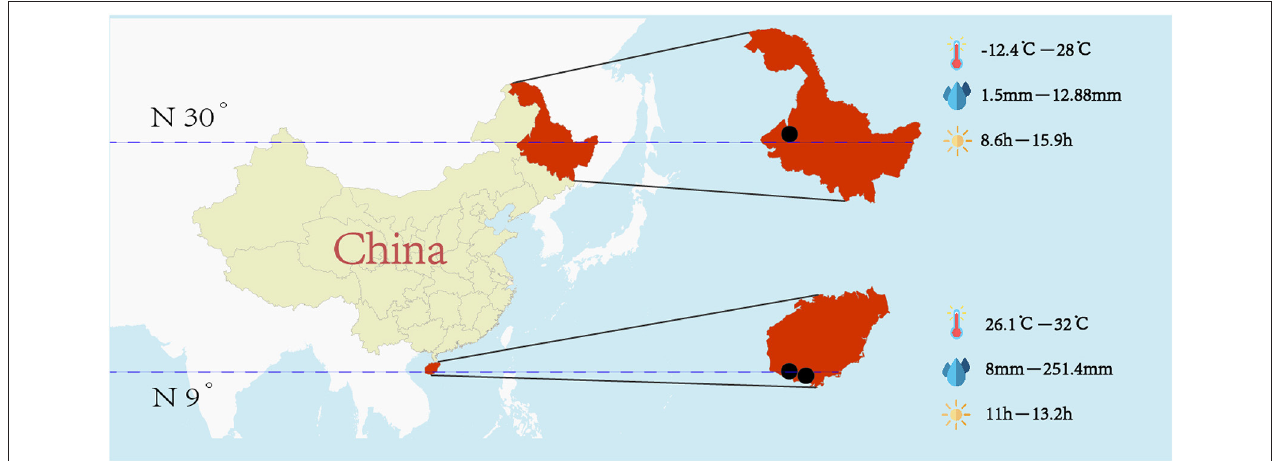
FIGURE 1 | Geographical location and climatic characteristics of the three sample troops. including 560 sailors in total, in this study. In the temperate zone, we included three platoons with a total of 86